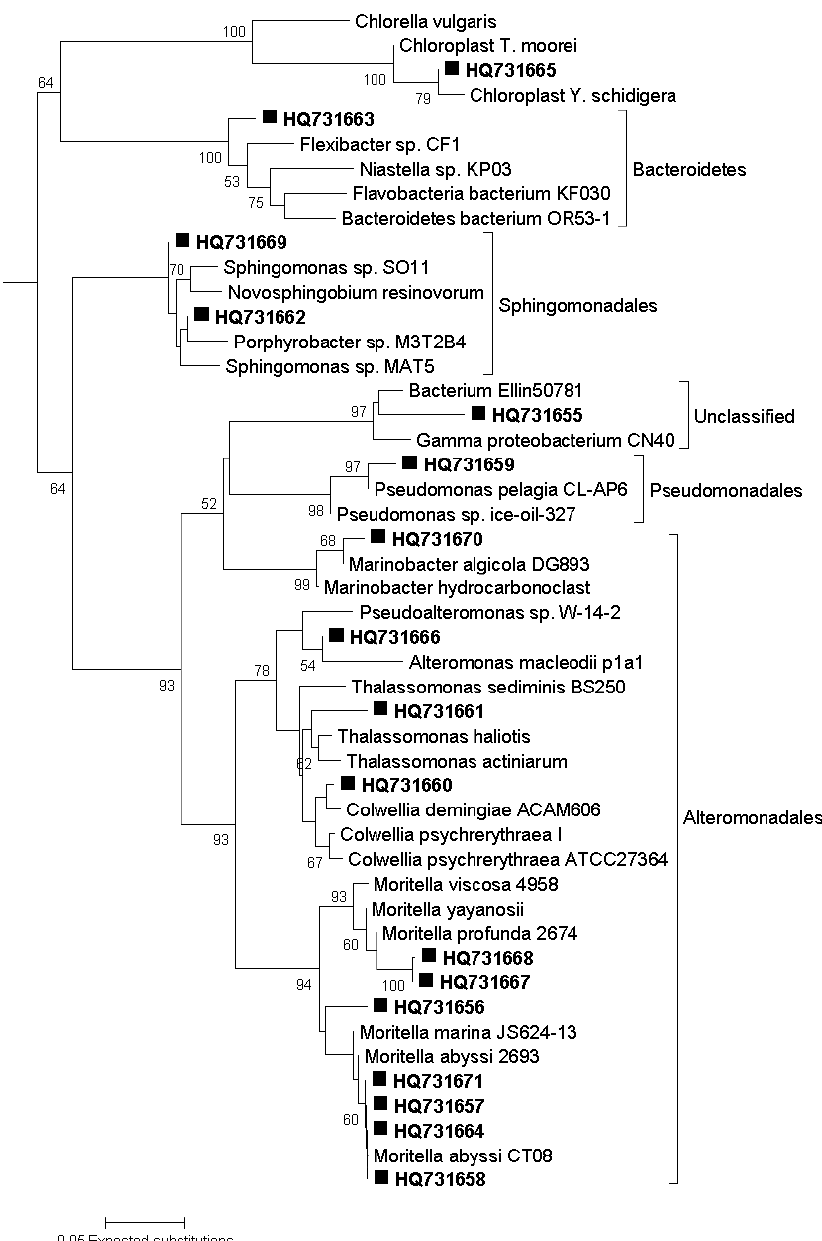
Figure 4. Evolutionary relationships of sequenced bacterial DGGE bands. Neighbor-Joining consensus tree of 16S rRNA V3 gene sequences obtained from DGGE analyses of bacterial communities in enrichment cultures. Bootstrap values were calculated from 2,000 replicates and only values >50% are shown. Scale bar represents the number of base substitutions per